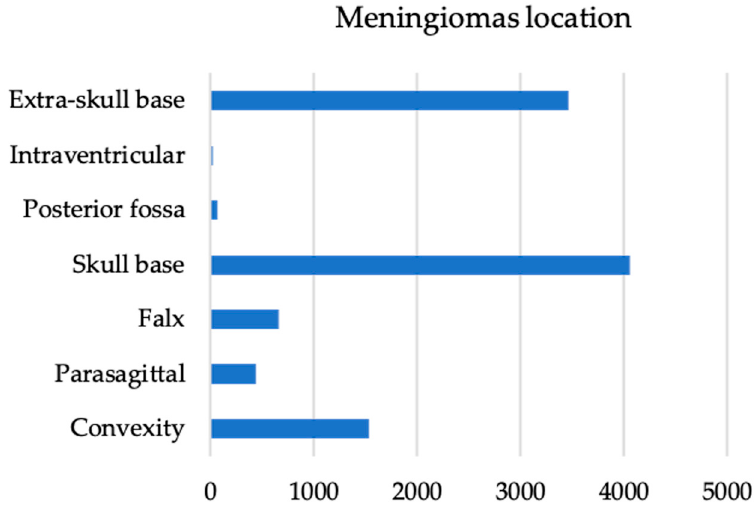
Figure 3. Diagram of the most frequent locations of meningiomas included in the papers selected for the present systematic review.